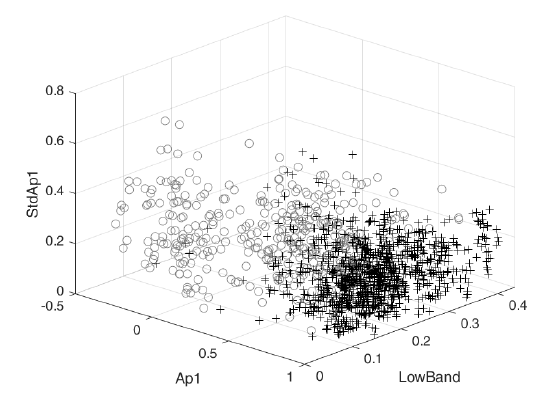
Figure 6. Feature space of the most frequently selected combination of three features: The amplitude of the first peak of the ACF of the entire segment (Ap1), the lower boundary of the bandwidth of the entire segment (LowBand) and the standard deviation of the Ap1 for the smaller segments (StdAp1). ‘+’ indicates clean signals and ’o’ indicates noisy signals.